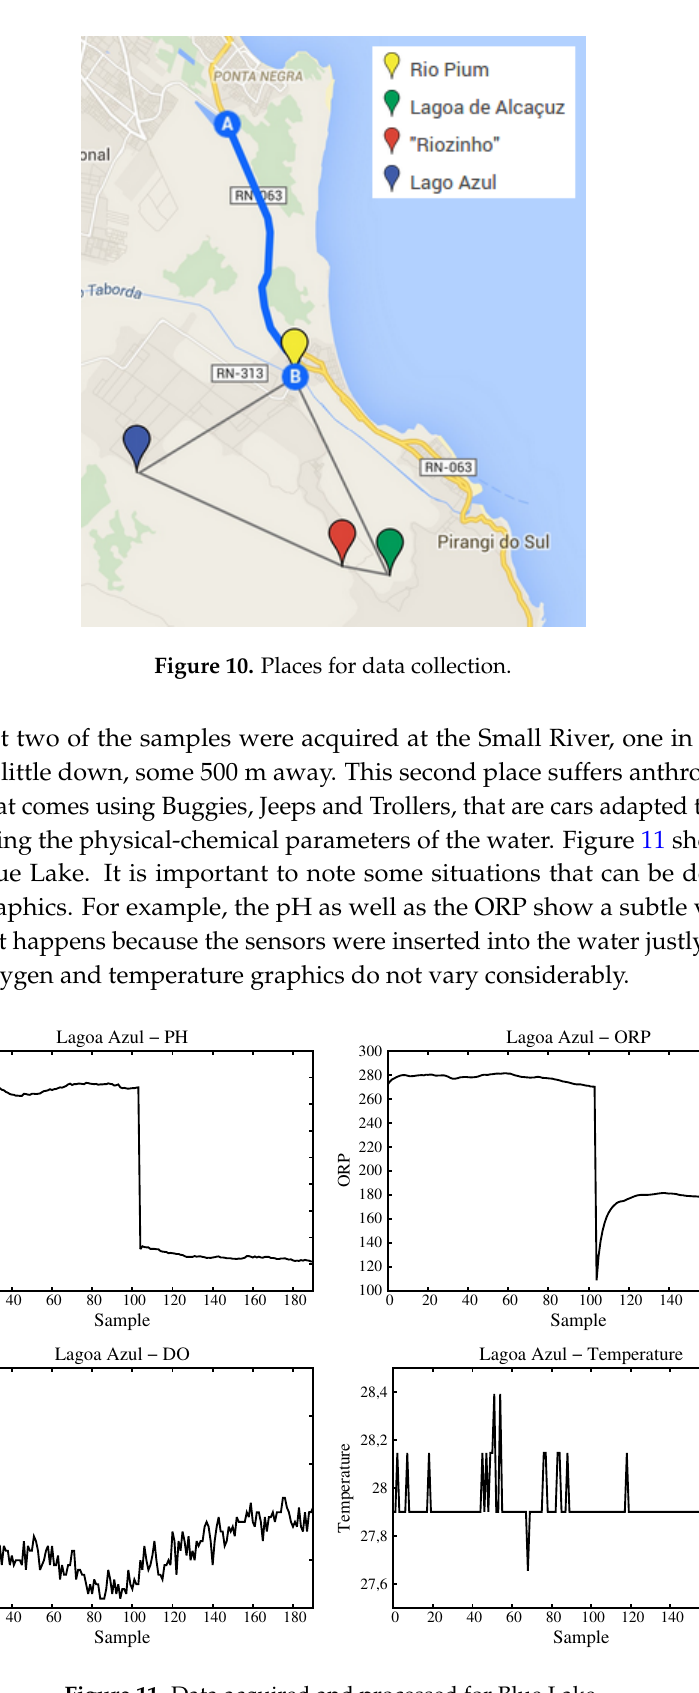
Figure 11. Data acquired and processed for Blue